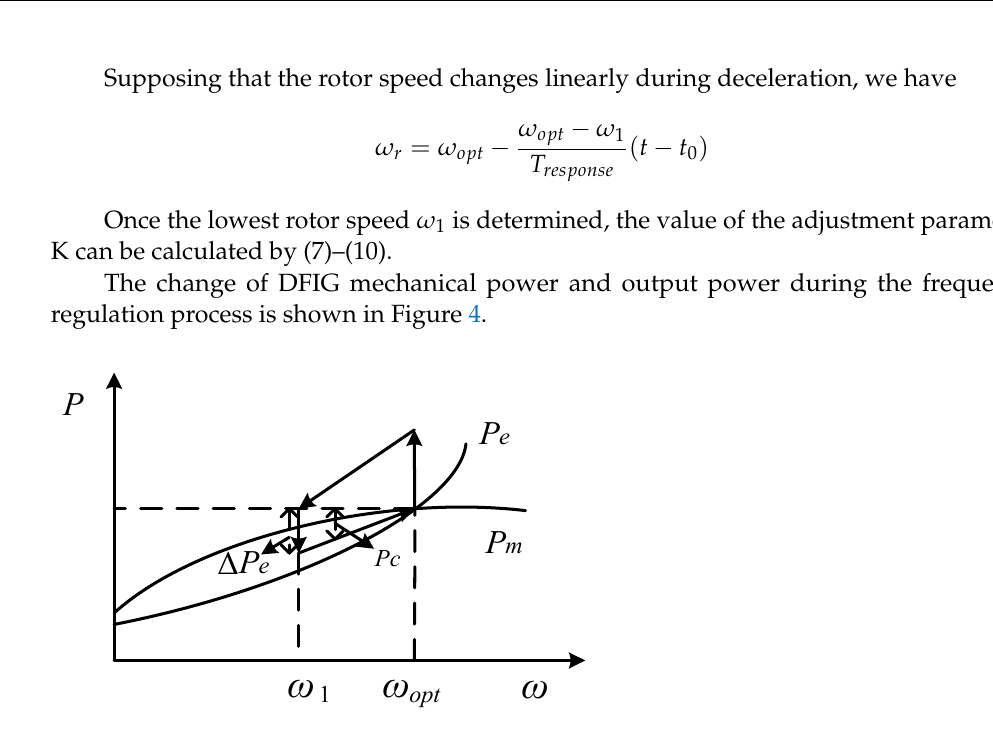
Figure 4. Variation curve of rotor speed and output power under improved control strategy.